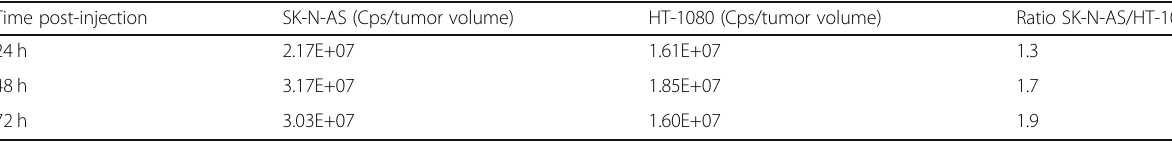
Table 3 SPECT imaging of tumor uptake at 24, 48, 72 h Time post-injection SK-N-AS (Cps/tumor